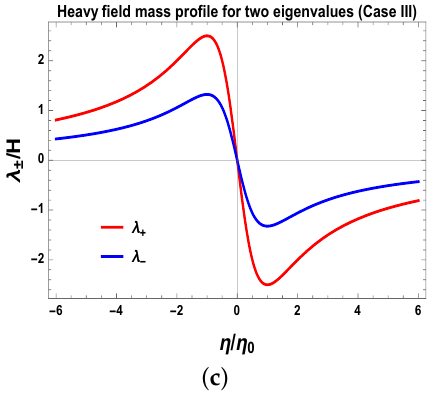
Figure 6. Conformal time scale dependent behaviour of heavy particle mass profile for two